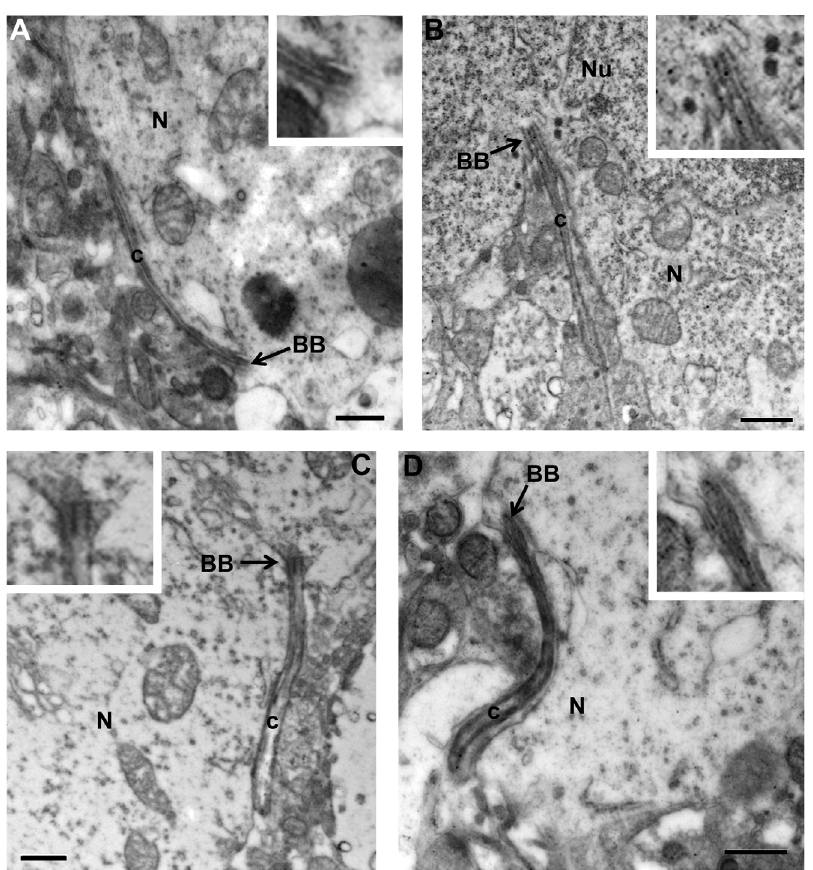
Figure 7. Transmission electron microscopic images of PNC in AcbSh (A), SCN (B), Pr5Vl (C) and DTg (D) of Bbs4 -/- mice. The morphologically intact elongated PNC containing axonemal microtubules and their basal bodies associated with neurons in four areas not known to contribute to the human phenotype or functional deficits in the Bbs4 -/- animal model are illustrated. Insets in each figure demonstrate the basal bodies of the cilia at higher magnification. No overt differences in morphology of PNC in these regions were observed compared to those of wild type animals (see Figure 2). The data for was collected from three WT and five Bbs4 -/- mice. BB – basal bodies; c – cilium; N -neuron; Nu – nucleus; arrows point to BB. Scale bars: 0.5 m m for A-D. Abbreviations as for Figure 6.